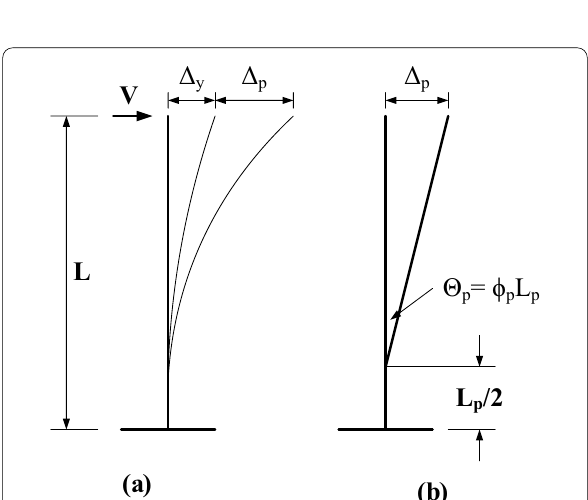
Fig. 4 Displacement profile and plastic rotation based on the plastic hinge concept: a displacement profile and b plastic rotation about the approximated hinge (Fedak,